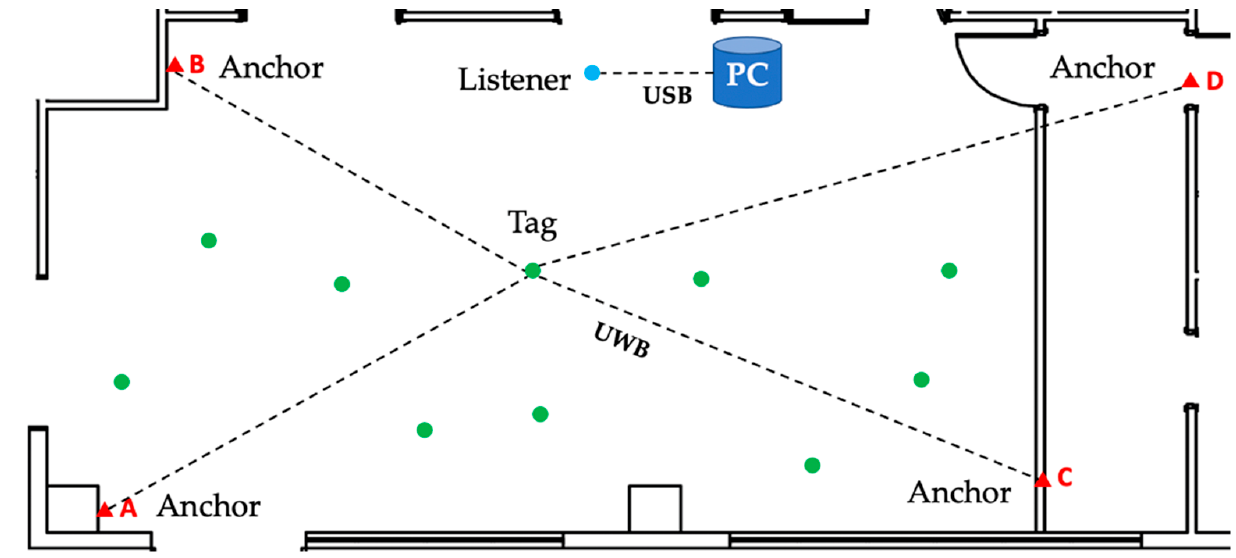
Figure 3. Topology of the RTLS network.